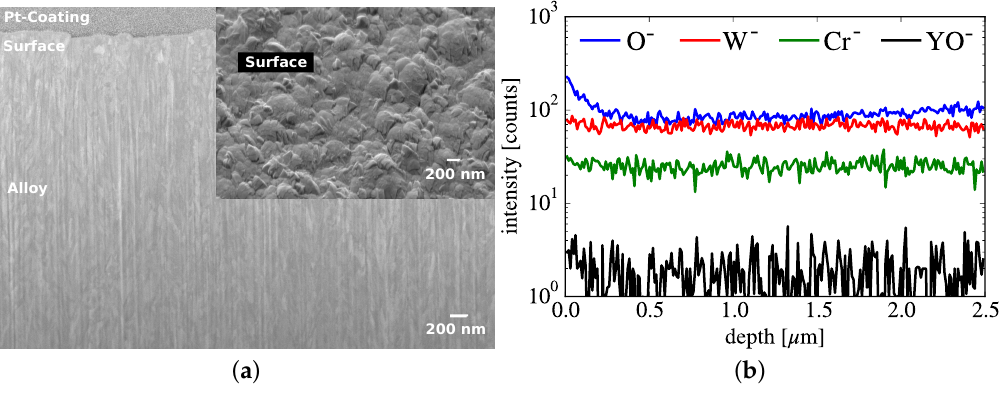
Figure 1. ( a ) Electron microscopy images of an W-13Cr-1Y alloy as deposited, exemplary for the alloys used in this work. The inset shows the surface, the cross-sectional view depicts the protective platinum (Pt) coating and the alloy; ( b ) SIMS profile of an exemplary W-12Cr-0.5Y alloy as deposited.